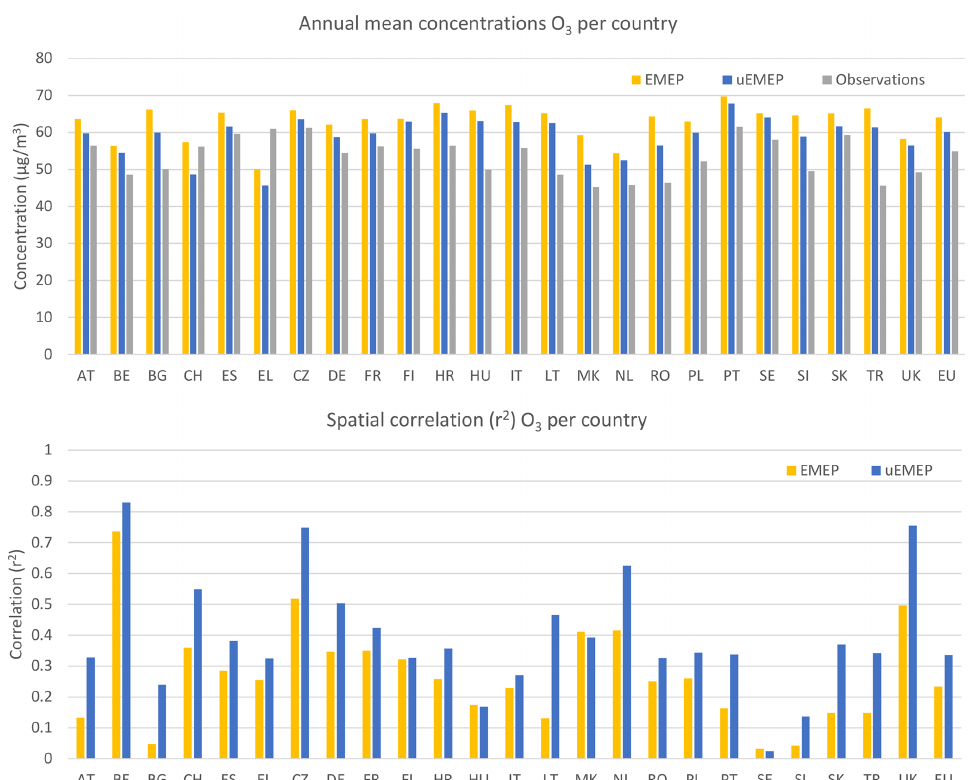
Figure 10. Annual mean O 3 concentrations and spatial correlation (coefficient of determination r 2 ) per country for 2018 calculated with the EMEP model and uEMEP compared to AIRBASE observations including all types of stations. Only countries with 10 or more stations are shown, but all stations are included in the final EU result. A total of 1974 stations are included in the comparison.